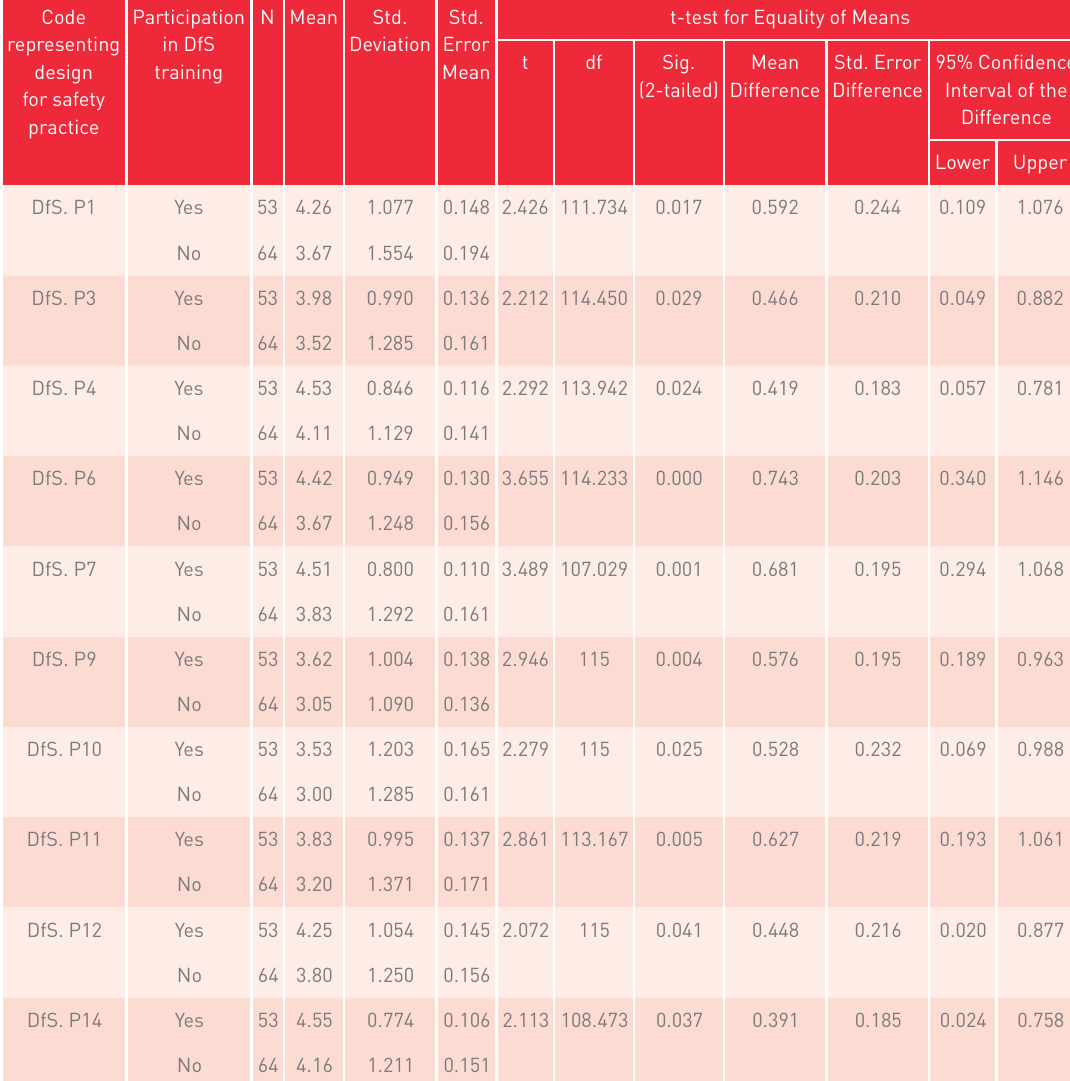
Table 10. Independent samples t-test based on DfS training.